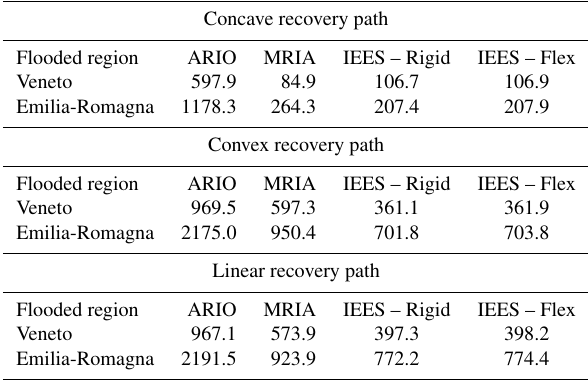
Figure 3. Overview of the study